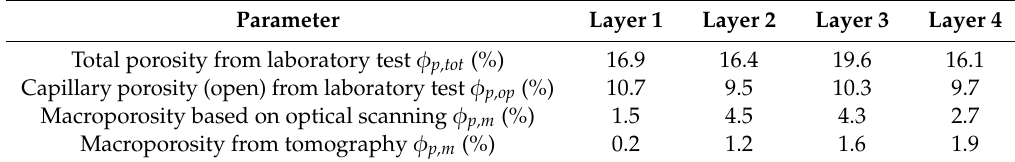
Table 5. Comparison of results for di ff erent types of porosity.